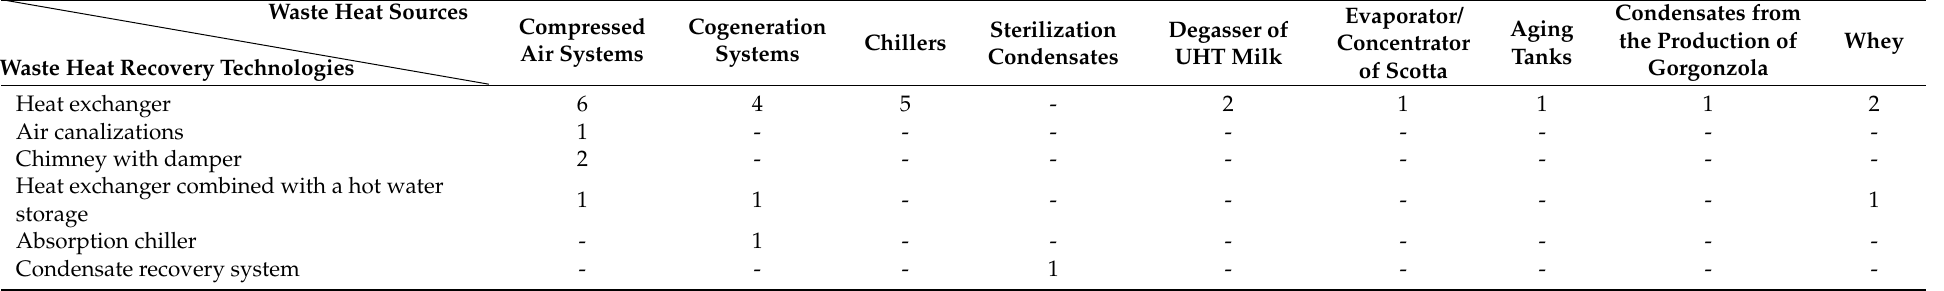
Table 4. Waste heat recovery technologies depending on the type of waste heat recovery